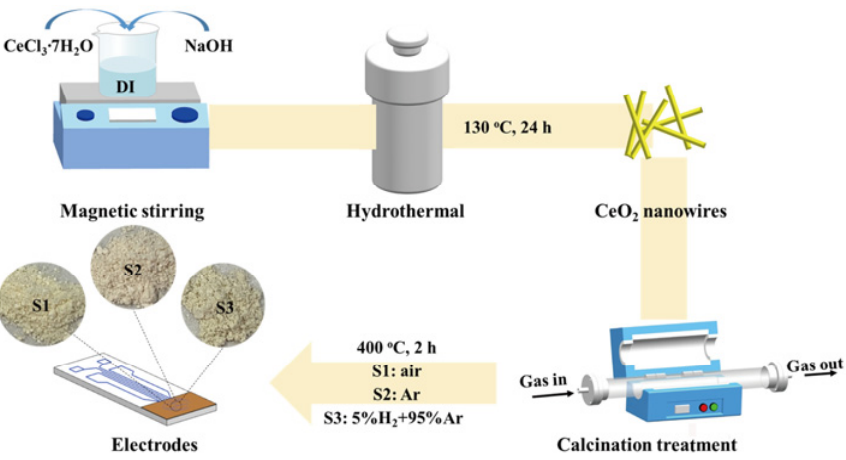
Fig. 1 Schematic illustrations of oxygen vacancy engineering on CeO 2